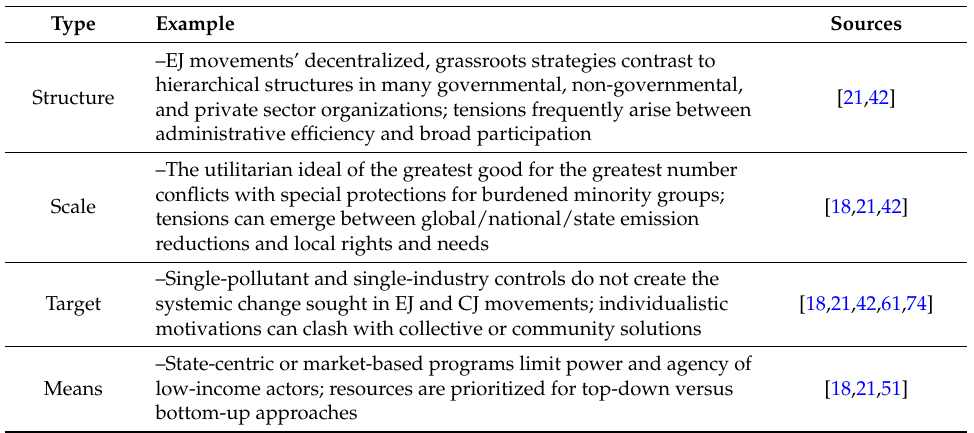
Table 8. Paradigmatic clashes.